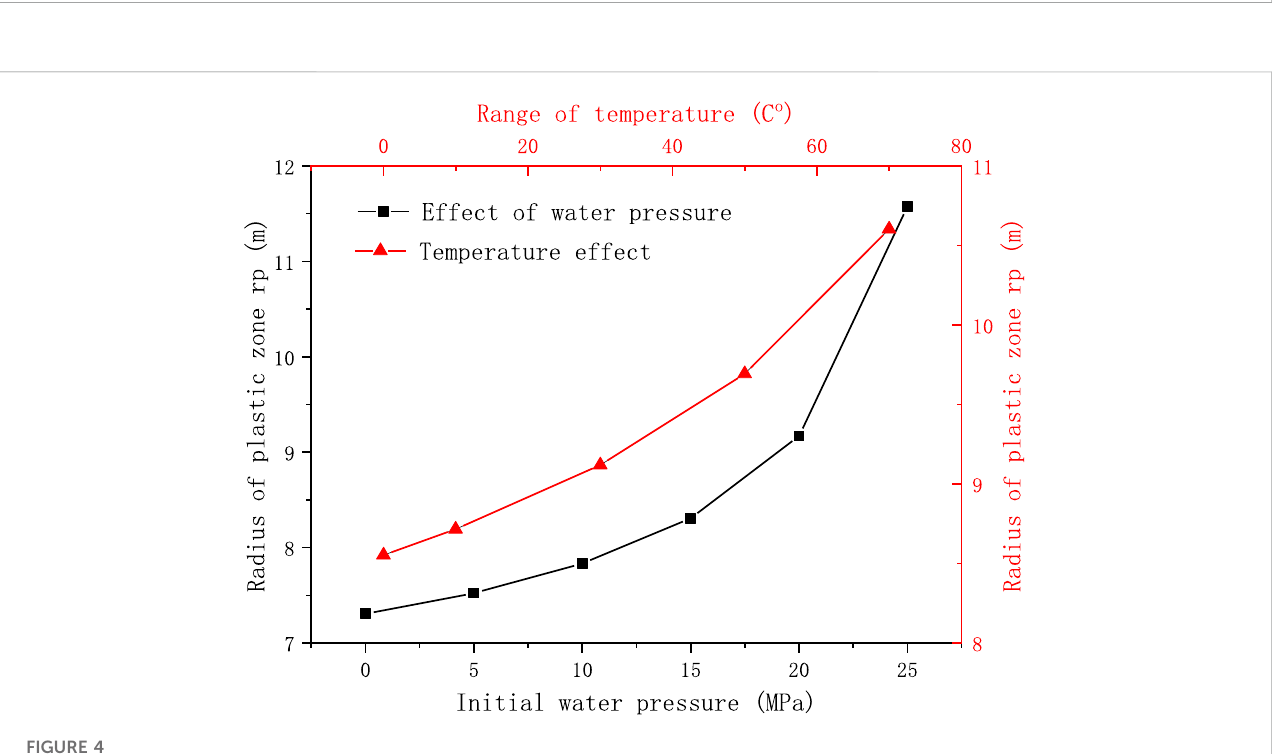
FIGURE 4 Effect of initial water pressure and temperature on plastic zone